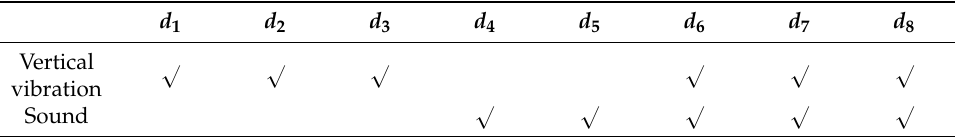
Table 5. Relationship of single-faults and signal types.